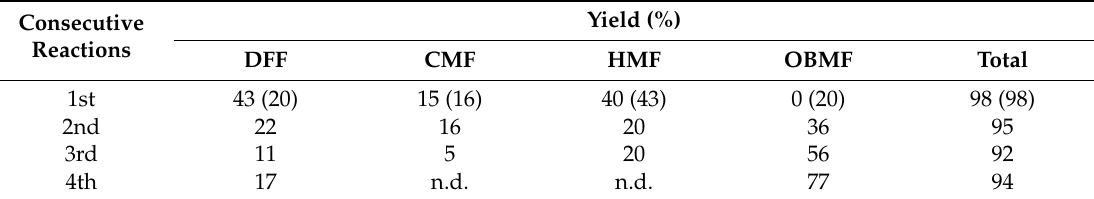
Table 4. Oxidation of CMF for four consecutive flow reactions using CuSO 4 · Si 10%.